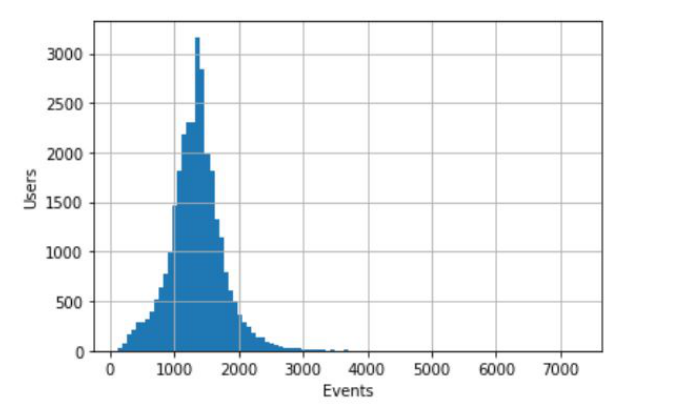
Figure 1. Histogram of the number of events per